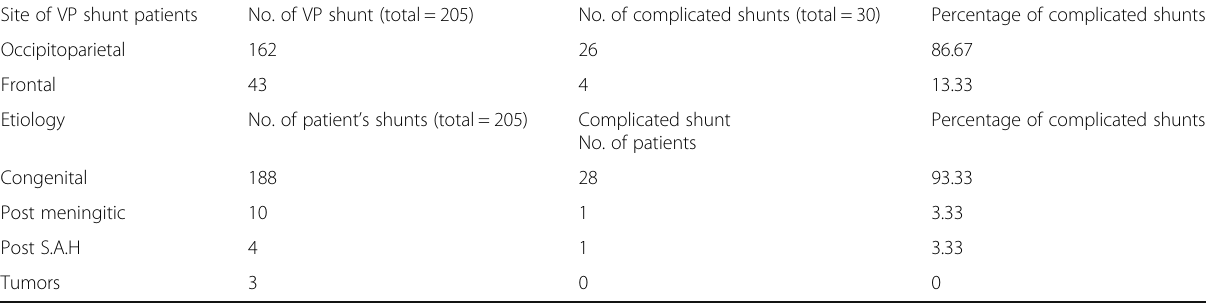
Table 2 Incidence of VP shunt complications in relation to site and etiology Site of VP shunt